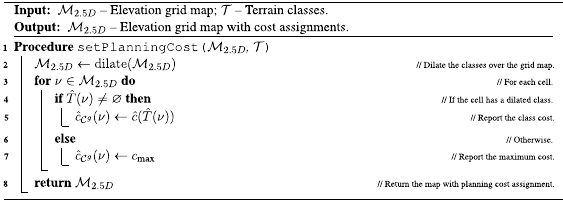
Algorithm 10. Set planning cost.